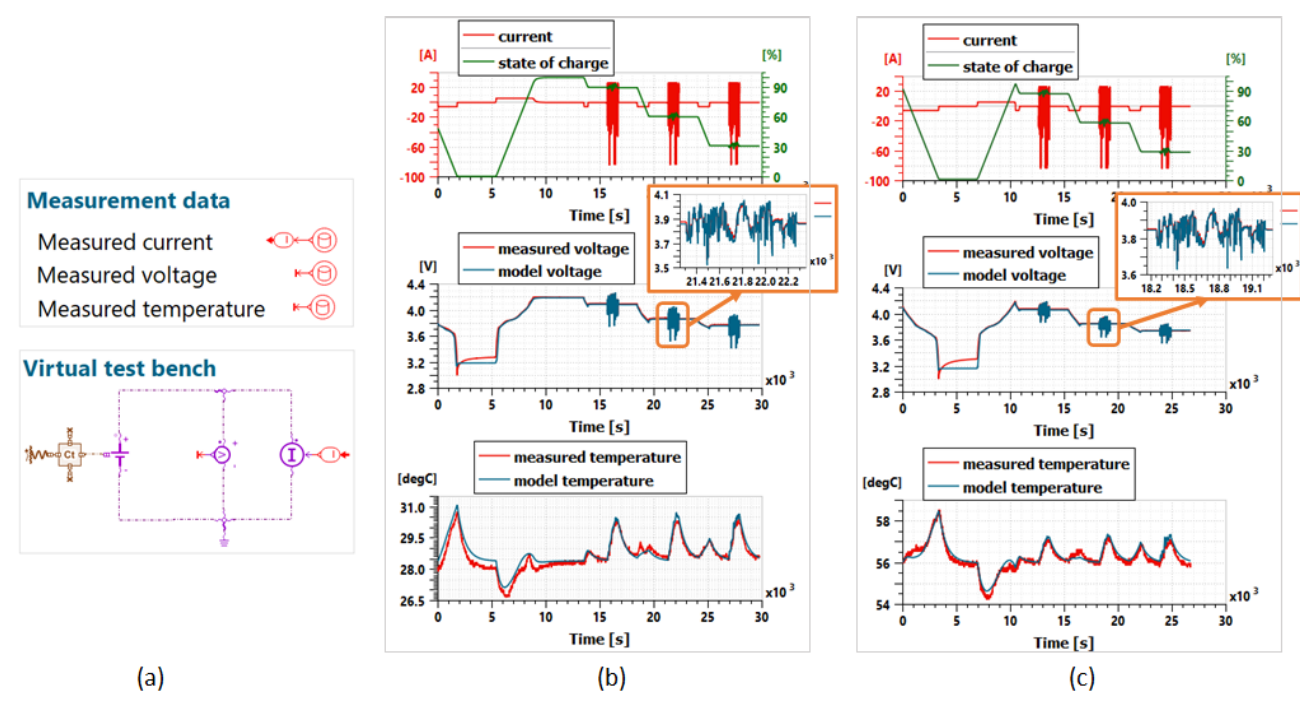
Figure 4. ( a ) Cell model validation in Simcenter Amesim; ( b ) and ( c ) comparison between model estimation and experimental data.